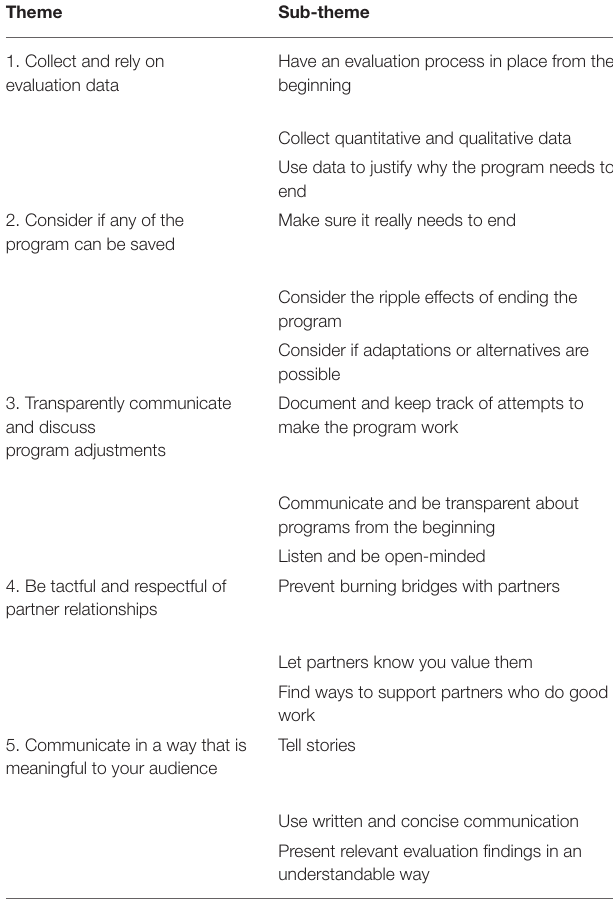
TABLE 2 | Themes and sub-themes of approaches for ending ineffective programs, United States,